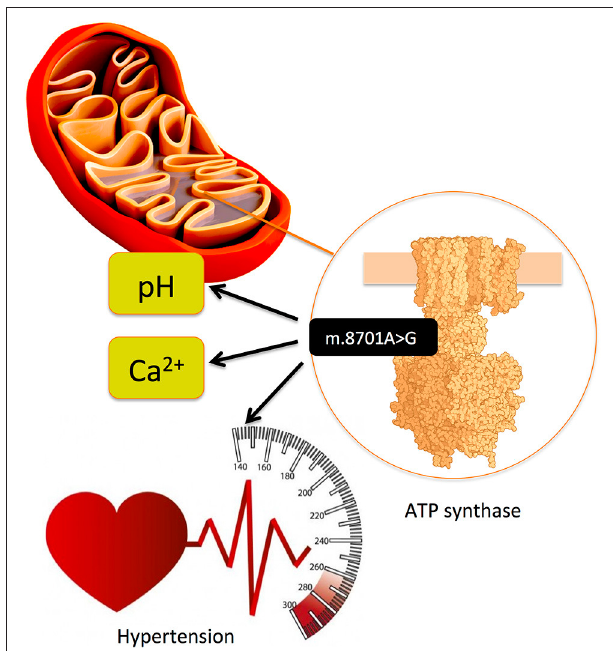
FIGURE 9 | Mitochondrial variant m.8701A > G is located in MT-ATP6 (ATP synthase/complex V F0 subunit 6) gene, which is part of the ATP synthase enzyme, responsible for the final step of oxidative phosphorylation and has been associated with hypertension. ( 44) On the functional level, using transmitochondrial hybrid cells (cybrids), it has been shown that it alters mitochondrial matrix pH and intracellular calcium dynamics